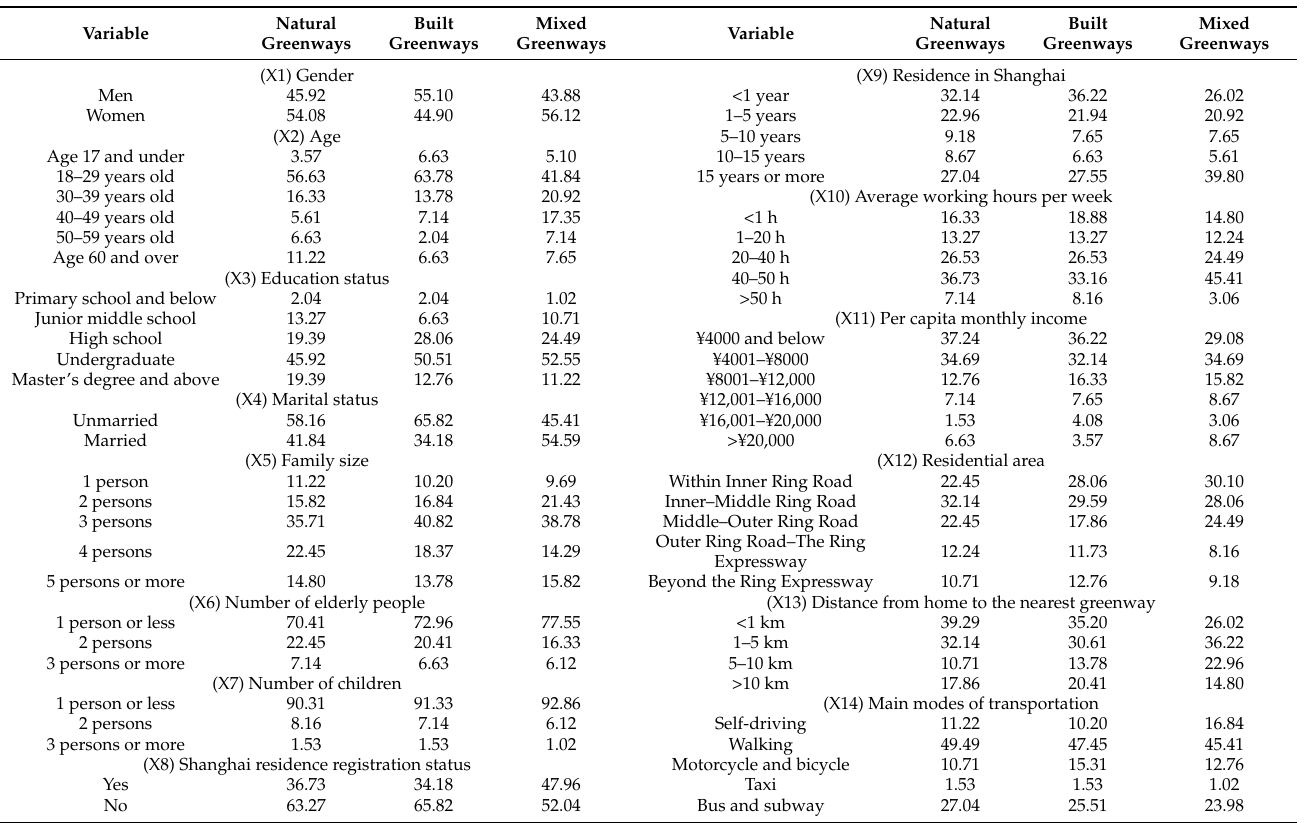
Table 2. Descriptive statistics of samples (%).